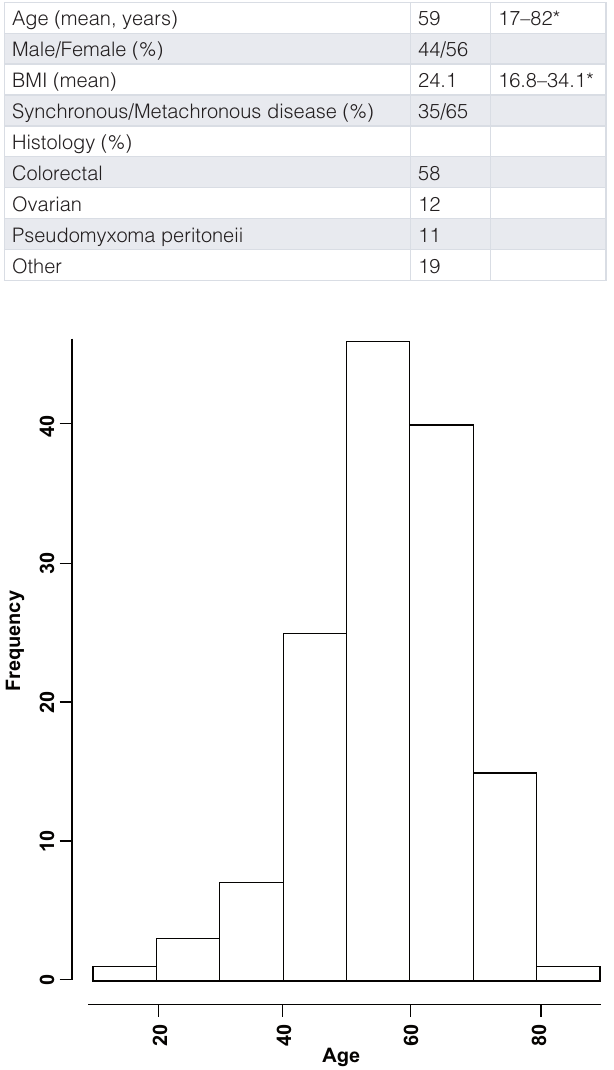
Figure 1. Distribution of age (years). Histogram of frequencies of ages of the included